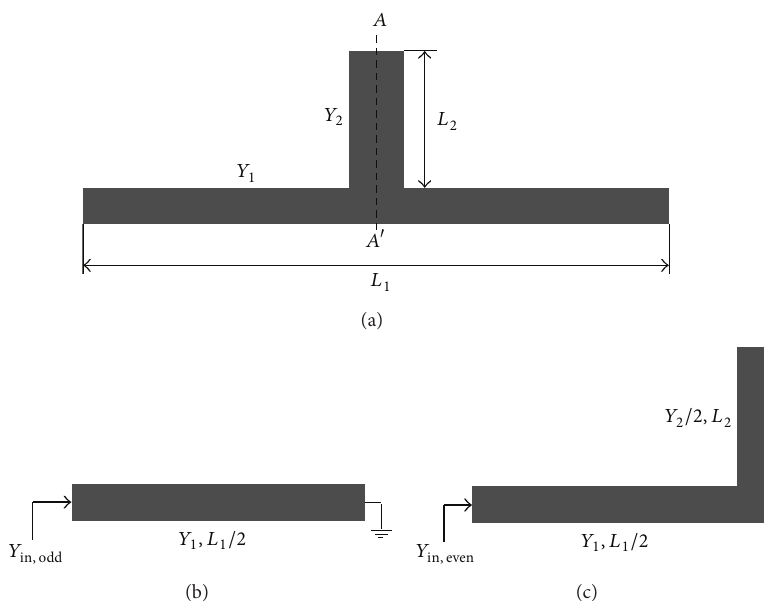
Figure 20: (a) Structure of the proposed stub-loaded resonator, (b) odd-mode equivalent circuit, and (c) even-mode equivalent circuit [4].